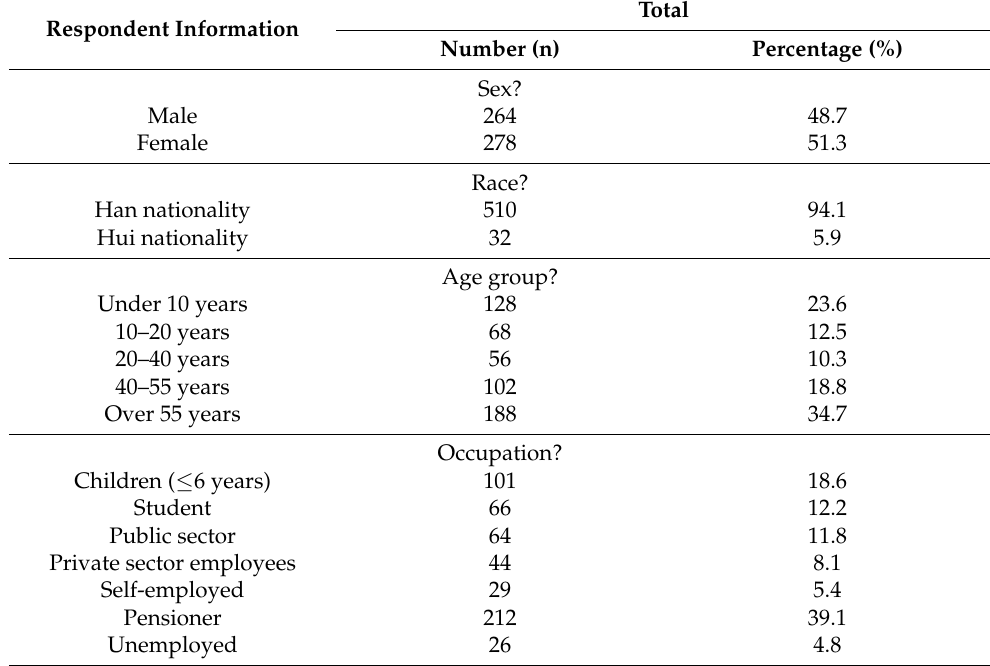
Table 2. Demographic information of the